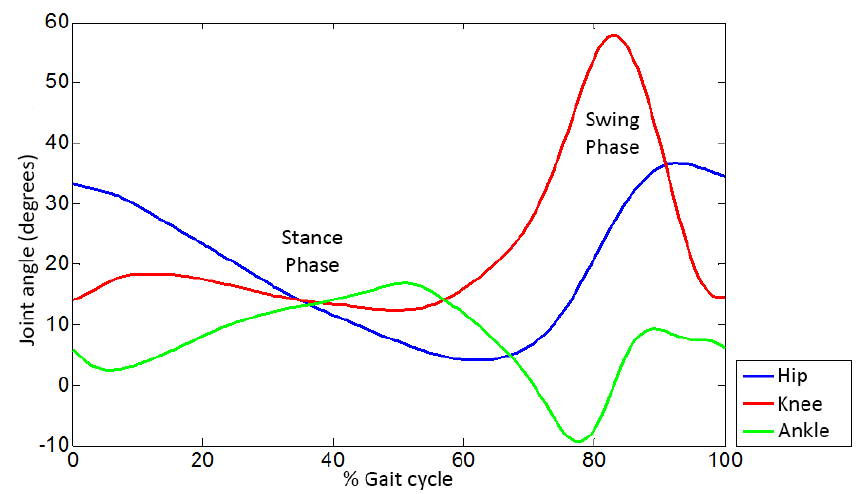
Figure 6. Ankle, knee and hip trajectories for the gait pattern.